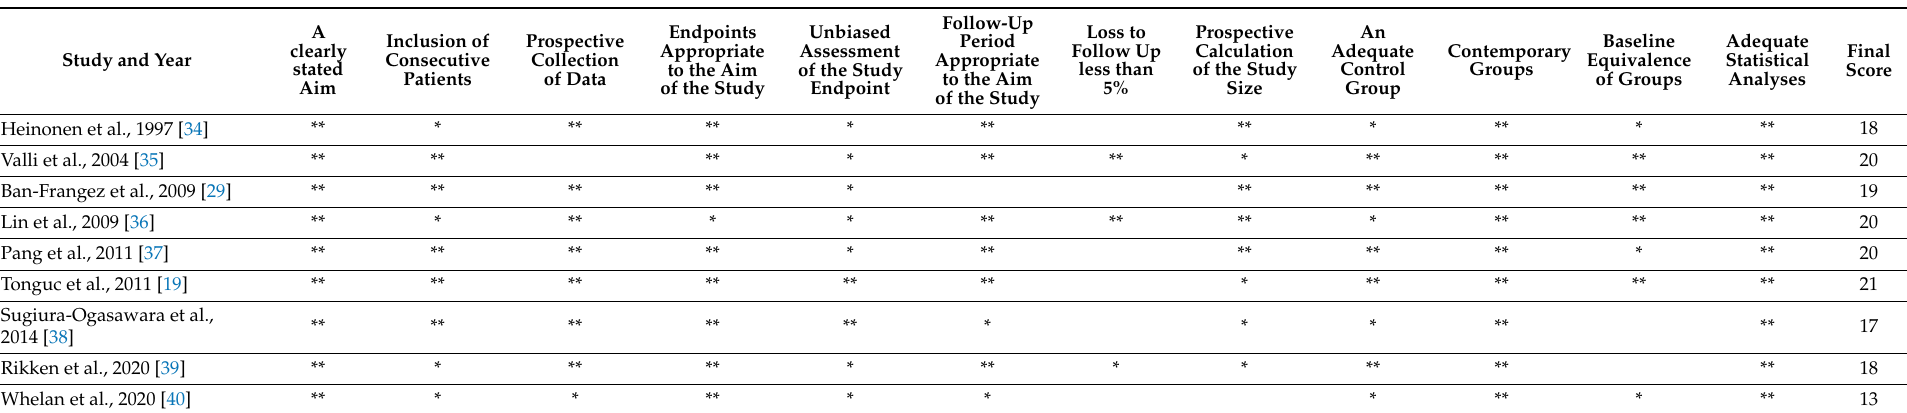
Table 5. Treated uterine septum versus controls (untreated septum)—comparative